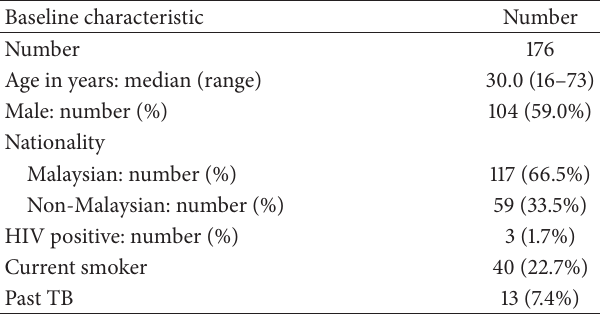
Table 2: Characteristics of outpatients enrolled at Luyang